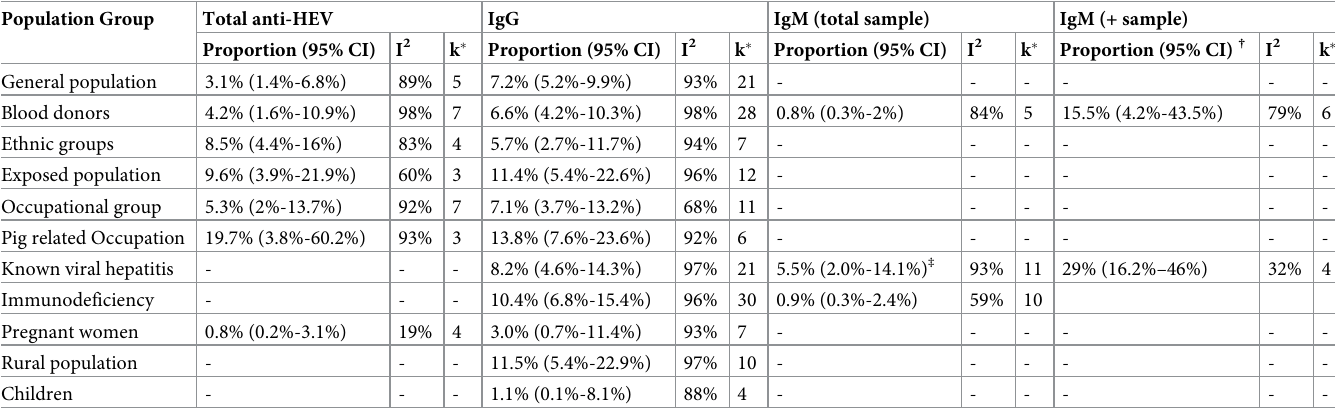
Table 1. Pooled analysis of HEV seroprevalence by population